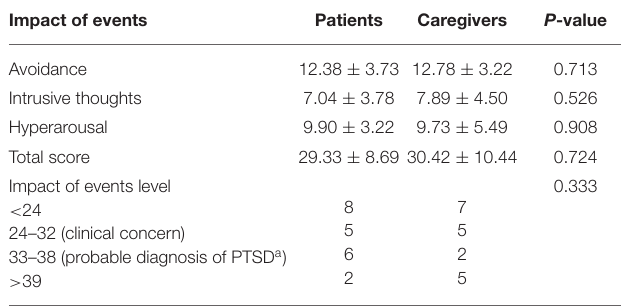
TABLE 1 | Demographic characteristics of patients and caregivers.